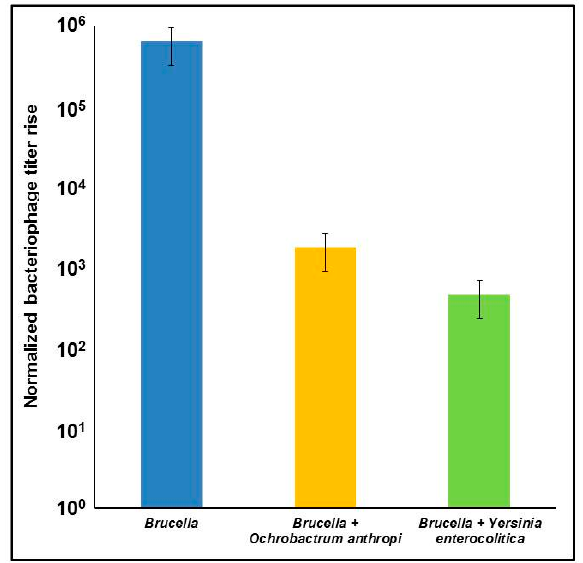
Figure 4. Brucellaphage Bk propagation on mixed bacterial cultures. Bacterial cultures overnight in Brucella Broth. The cultures were diluted 1:1000 with Brucella Broth and brucellaphage Bk was added to get a final concentration of 10 3 PFU/mL and approximate multiplicity of infection (MOI) of 1:1000. All cultures were incubated at 37 °C for 72 h with shaking at 200 rpm, treated with 10% chloroform; then a 0.5-mL aliquot was taken and centrifuged to remove cell debris. One microliter of each lysate was used for the qPCR reaction. For testing phage specificity in mixed cultures, equal volumes of diluted overnight non- Brucella and B . abortus S19 cultures were mixed, grown in the presence of the Bk phage and processed as described above.